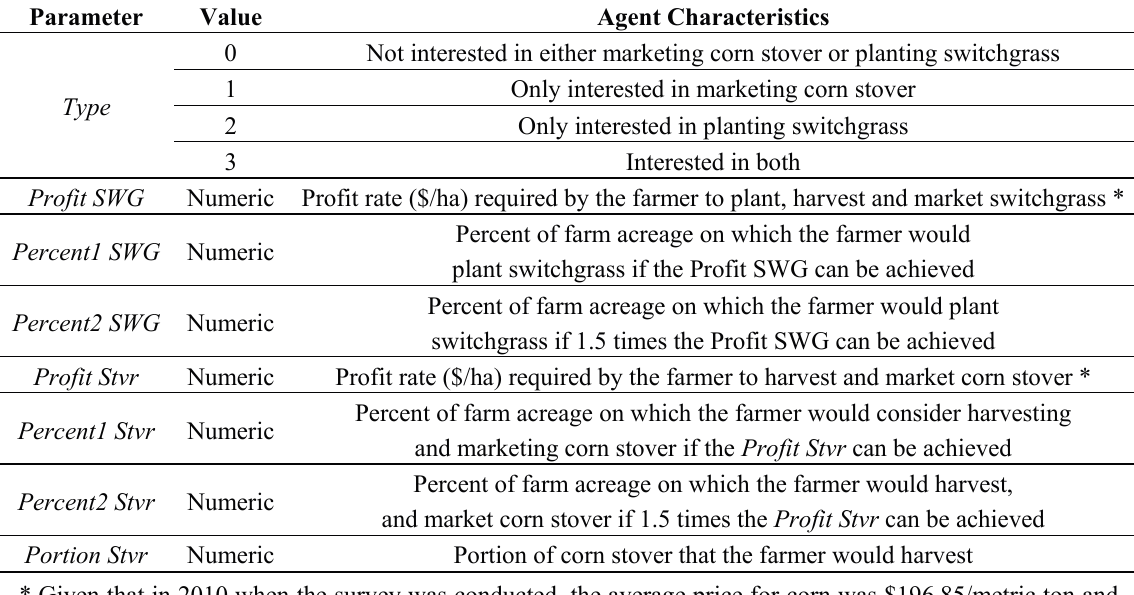
Table 1. Parameters characterizing farmers’ attitudes towards biofuel crop